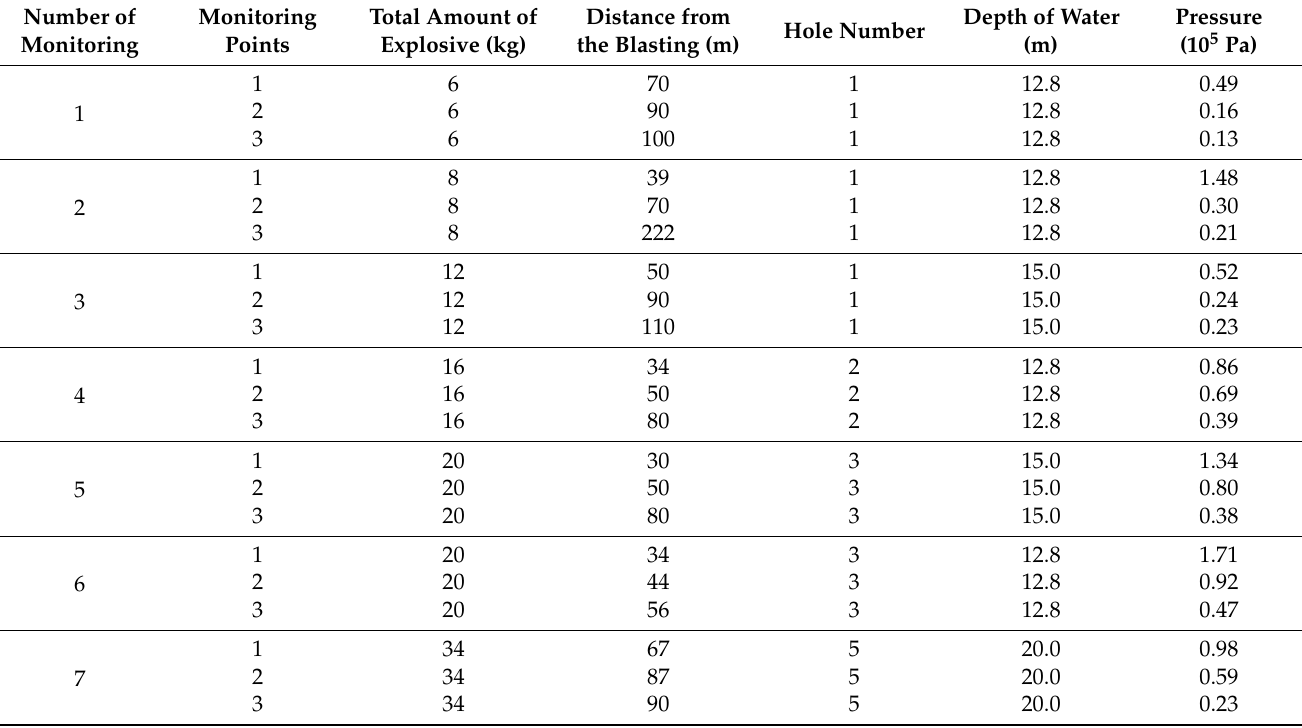
Table 1. The results of field monitoring.